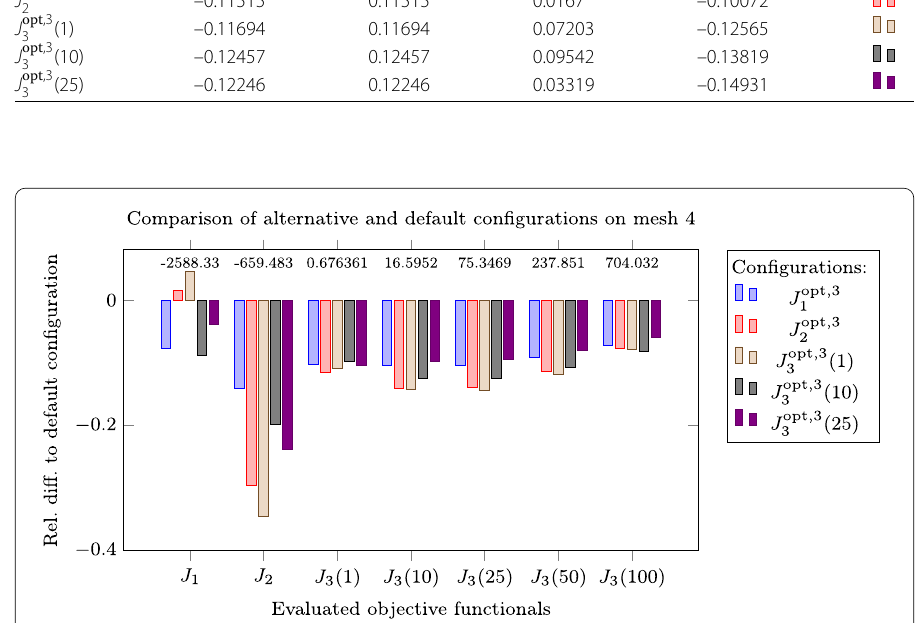
Figure 9 Optimization of nozzles’ positions. Relative differences of the objectives computed on mesh 4, i.e., the graph shows ( J ∗ – J default ∗ )/ | J default ∗ | . The numbers on top of the bars are the respective objective values for the default